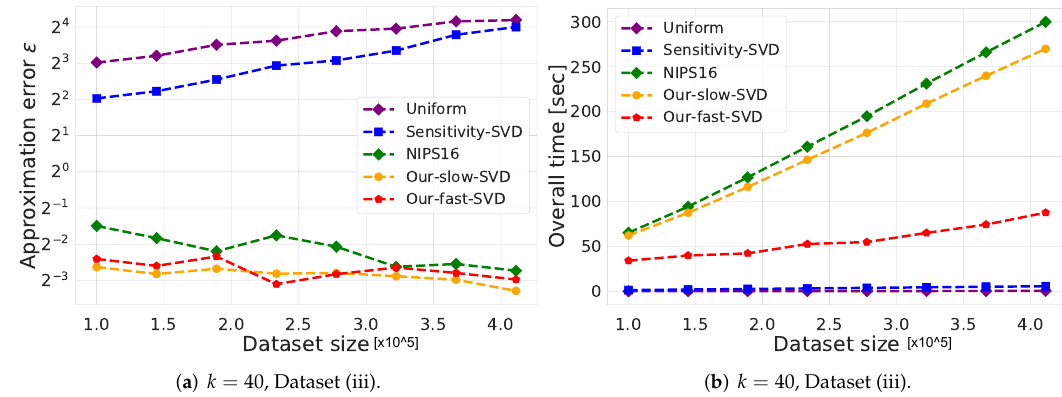
Figure 6. Experimental results for k -SVD, we used Dataset (iii). The x axis is the size of the dataset which we compress to subsample of size 150, while the y -axis is the approximation error in the left hand side graph, and in the right hand side it is the overall time took to compute the coreset and to solve the problem on